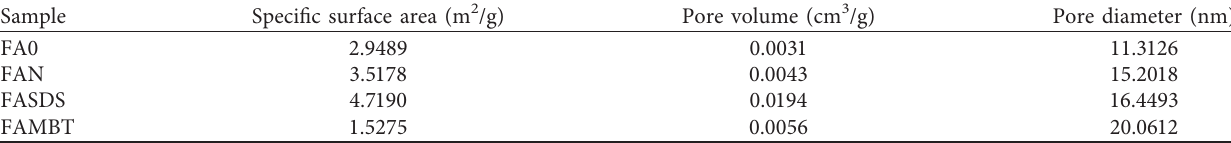
Table 3: Specific surface area, pore volume, and pore diameter of FA0, FAN, and modified FAN particles.